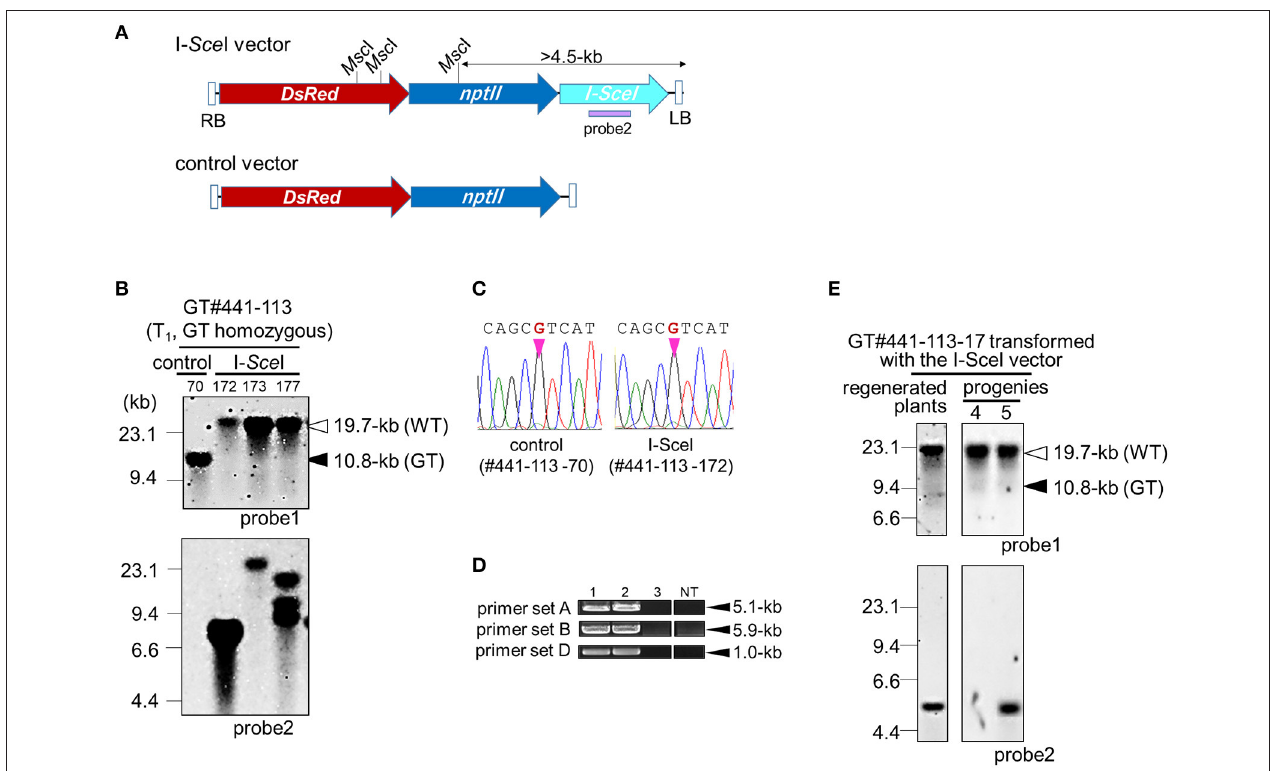
FIGURE 3 | Marker excision from GT locus in GT#441. (A) Schematic diagrams of T-DNA for the I- Sce I expression vector. The I-SceI vector (top) carries the I- Sce I gene under the control of CaMV 35S promoter, npt gene, and DsRed gene. The control vector (bottom) carries no I- Sce I expression cassette. A purple bar indicates probe 2 for Southern blot analysis. (B) Southern blot analyses with probe 1 or 2 using Eco RV or Msc I-digested genomic DNA, respectively. Samples are GT homozygous plants in the T 1 generation transformed with the I-SceI vector or control vector. White and black triangles indicated bands derived from the WT and marker-excised GT allele, and the GT allele, respectively. (C) Sequencing chromatograms at the mutation site on the OsCly1 gene in GT#441-113-70 and GT#441-113-172. (D) PCR analysis to confirm marker excision. Sample 1: regenerated plants of GT#441-113; samples 2 and 3: GT homozygous plants of GT#441-113-70 and GT#441-113-172 transformed with control and I-SceI vector, respectively. NT; non-transformant. (E) Southern blot analyses with probe 1 or 2 using Eco RV- or Msc I-digested genomic DNA, respectively. Samples are regenerated plants and the progenies of GT homozygous plants of GT#441-113-17 (T 1 generation) transformed with the I-SceI vector. Details as in (B)